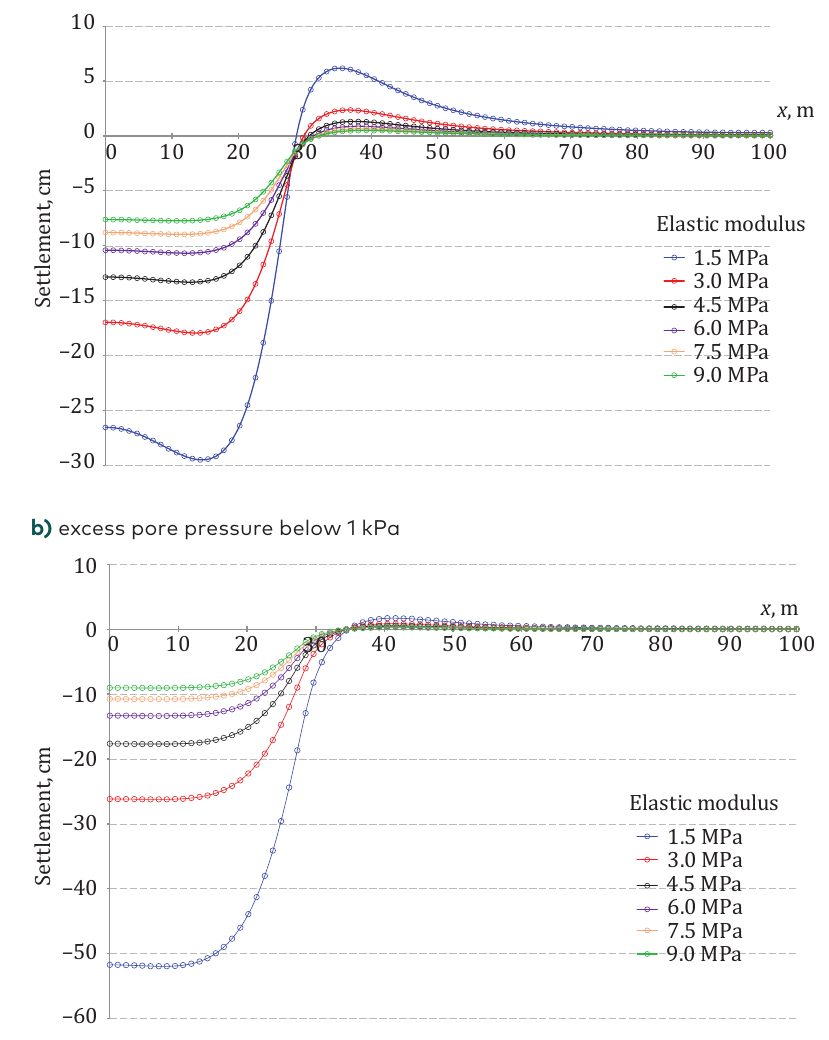
Figure 11. Relationship between ground settlement and elastic